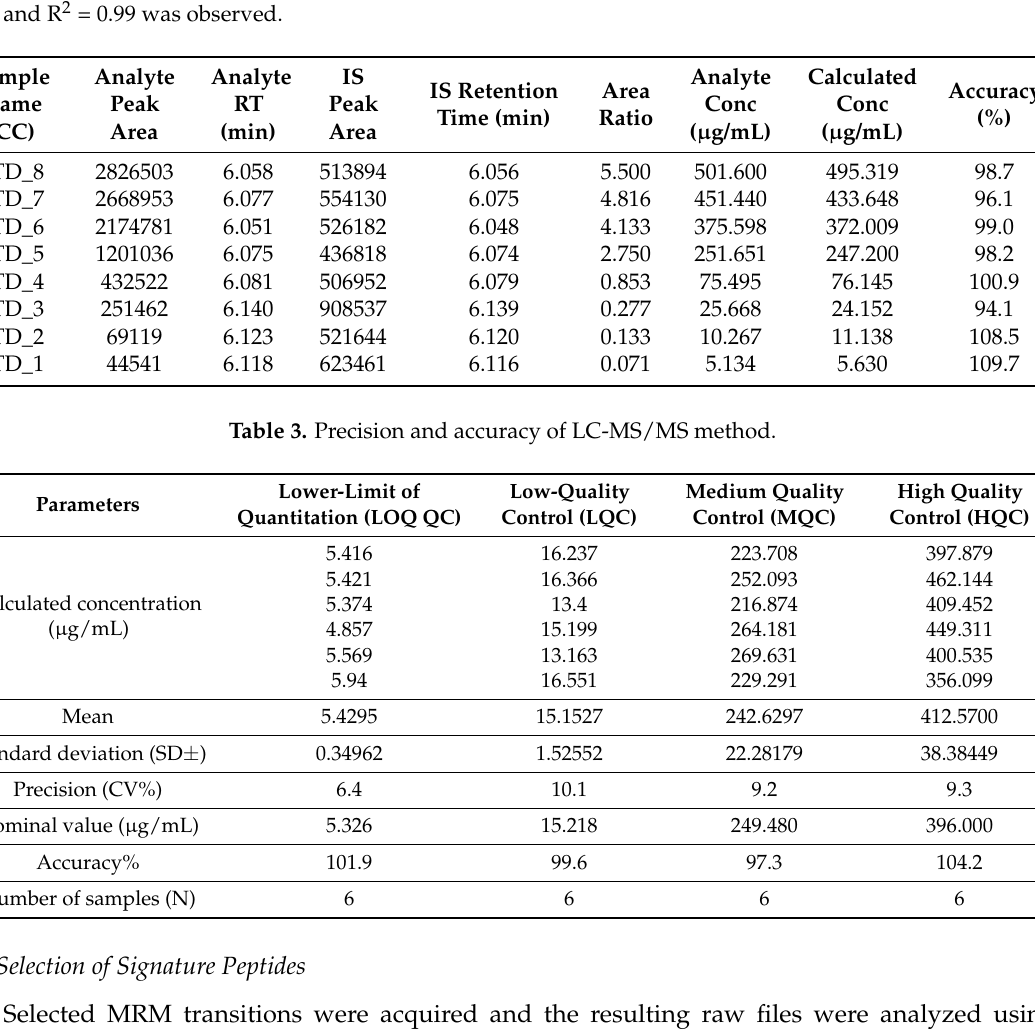
Table 2. Quantification data of trastuzumab signature peptide (FTISADTSK) in human serum batch; calibration curve (CC) extends from 5 µ g/mL to 500 µ g/mL; their corresponding accuracy percentage and R 2 = 0.99 was observed.